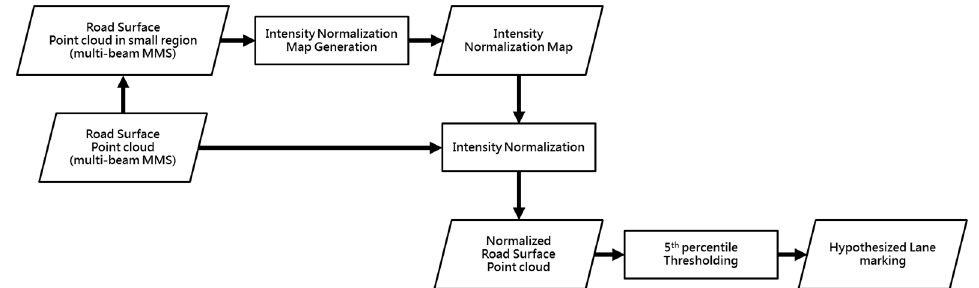
Figure 7. Flowchart of the normalized intensity thresholding strategy for a multi-beam LiDAR-based MMS.